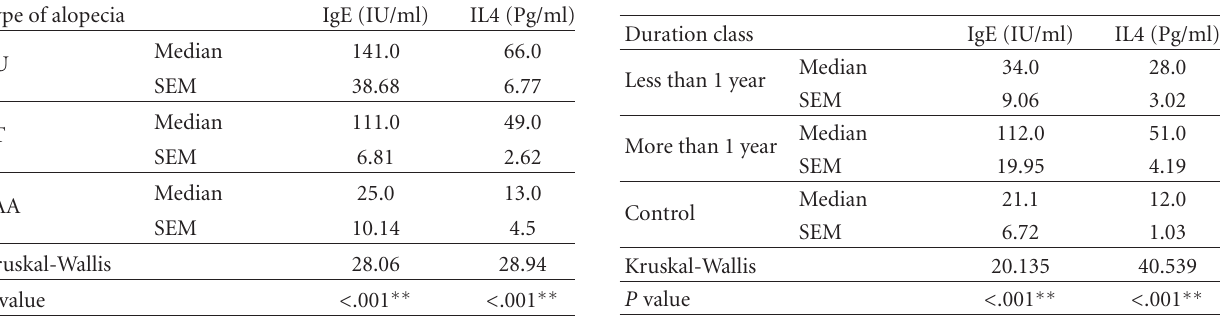
Table 3: Comparison between IgE and IL4 levels in patients with disease duration less and more than 1 year and controls using Kruskal-Wallis